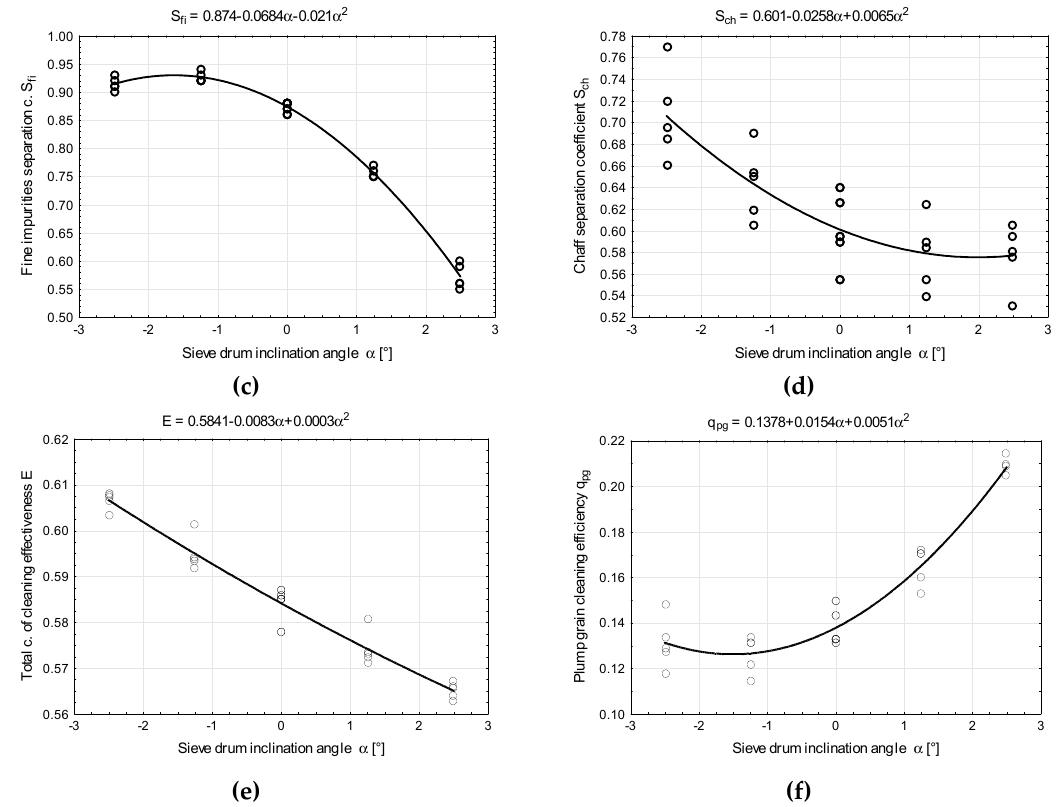
Figure 3. Analysis of the influence of the sieve drum inclination angle on the cleaning process for ν d = 5 rpm: (a) plump grain separation coefficient S pg , (b) fine grain separation coefficient S fg , (c) fine impurities separation coefficient S fi , (d) chaff separation coefficient S ch , (e) total coefficient of cleaning effectiveness E , (f) plump grain cleaning efficiency q pg .